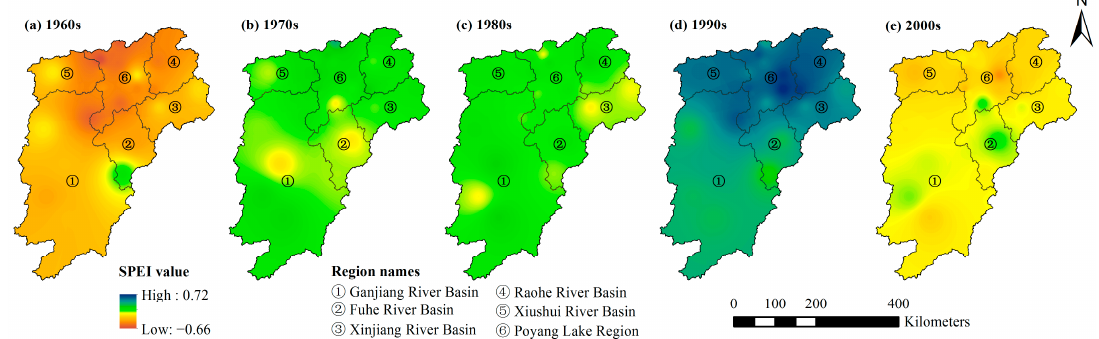
Figure 8. Spatial-temporal distribution of the SPEI on a 12-month timescale in the Poyang Lake Basin. ( a ) 1960s; ( b ) 1970s; ( c ) 1980s; ( d ) 1990s; ( e ) 2000s.